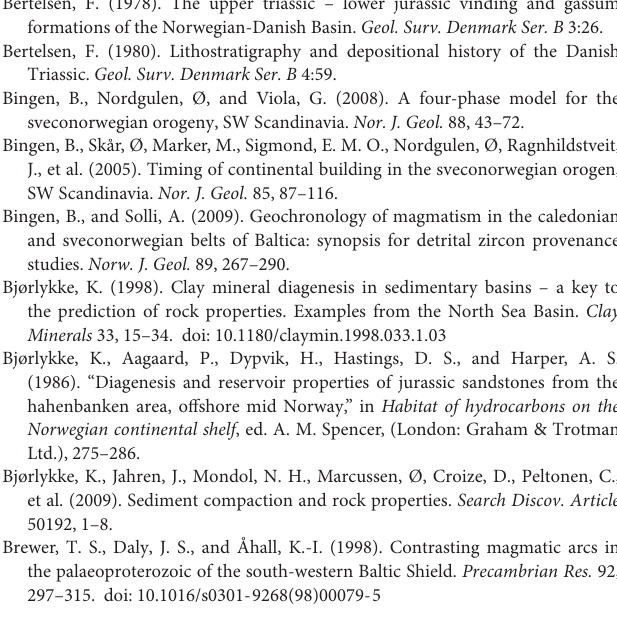
FIGURE S1 | Cathodoluminescence photo of detrital zircon grains from the Gassum Formation used for U-Pb age dating. FIGURE S2 | X-ray diffraction results of samples from the Gassum Formation in the Skagerrak. TABLE S1 | Zircon U-Pb age data from the Gassum Formation in the